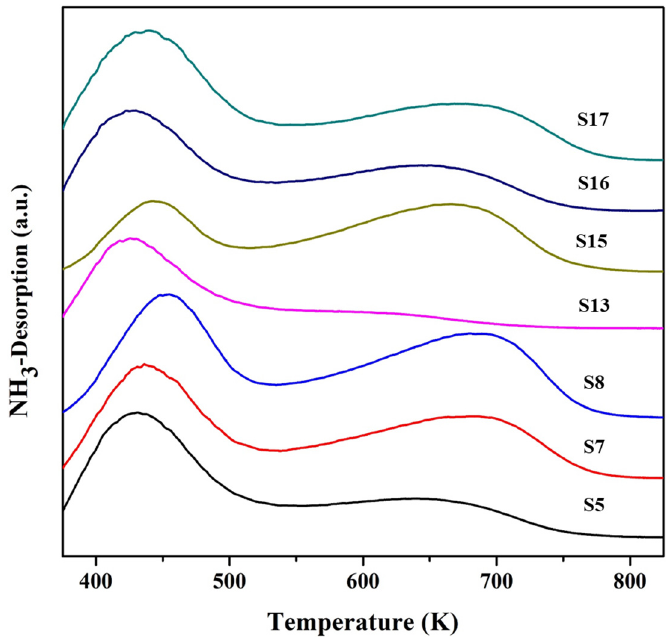
Figure 9. The effect of SiO 2 concentration ( z ) in the gel solution on the Si/Al ratio, P/Al ratio, and Si incorporation for the synthesized SAPO-34 particles.